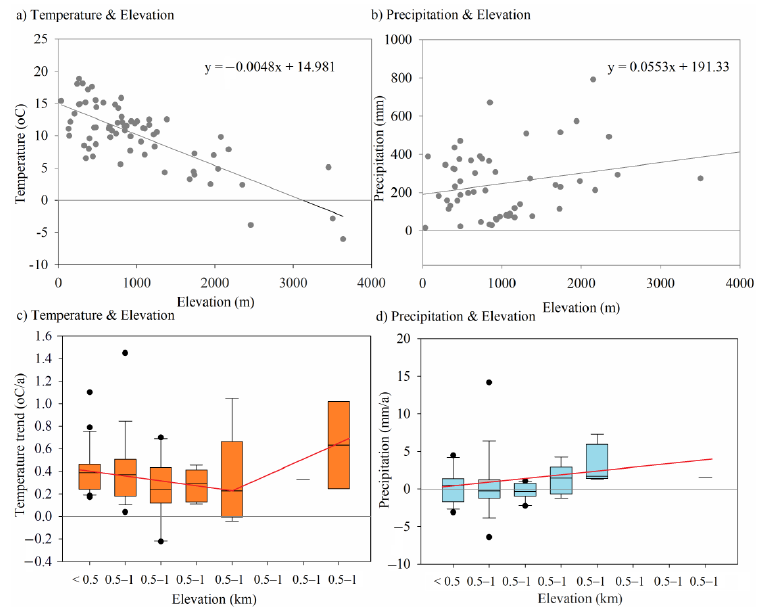
Figure 11. Variations in annual temperature and precipitation in the TS from 1990 to 2015. ( a ) Variations in temperature from the meteorological stations; ( b ) variations in temperature from the ERA5 data; ( c ) variations in precipitation from the meteorological stations; ( d ) variations in precipitation from the GPCC